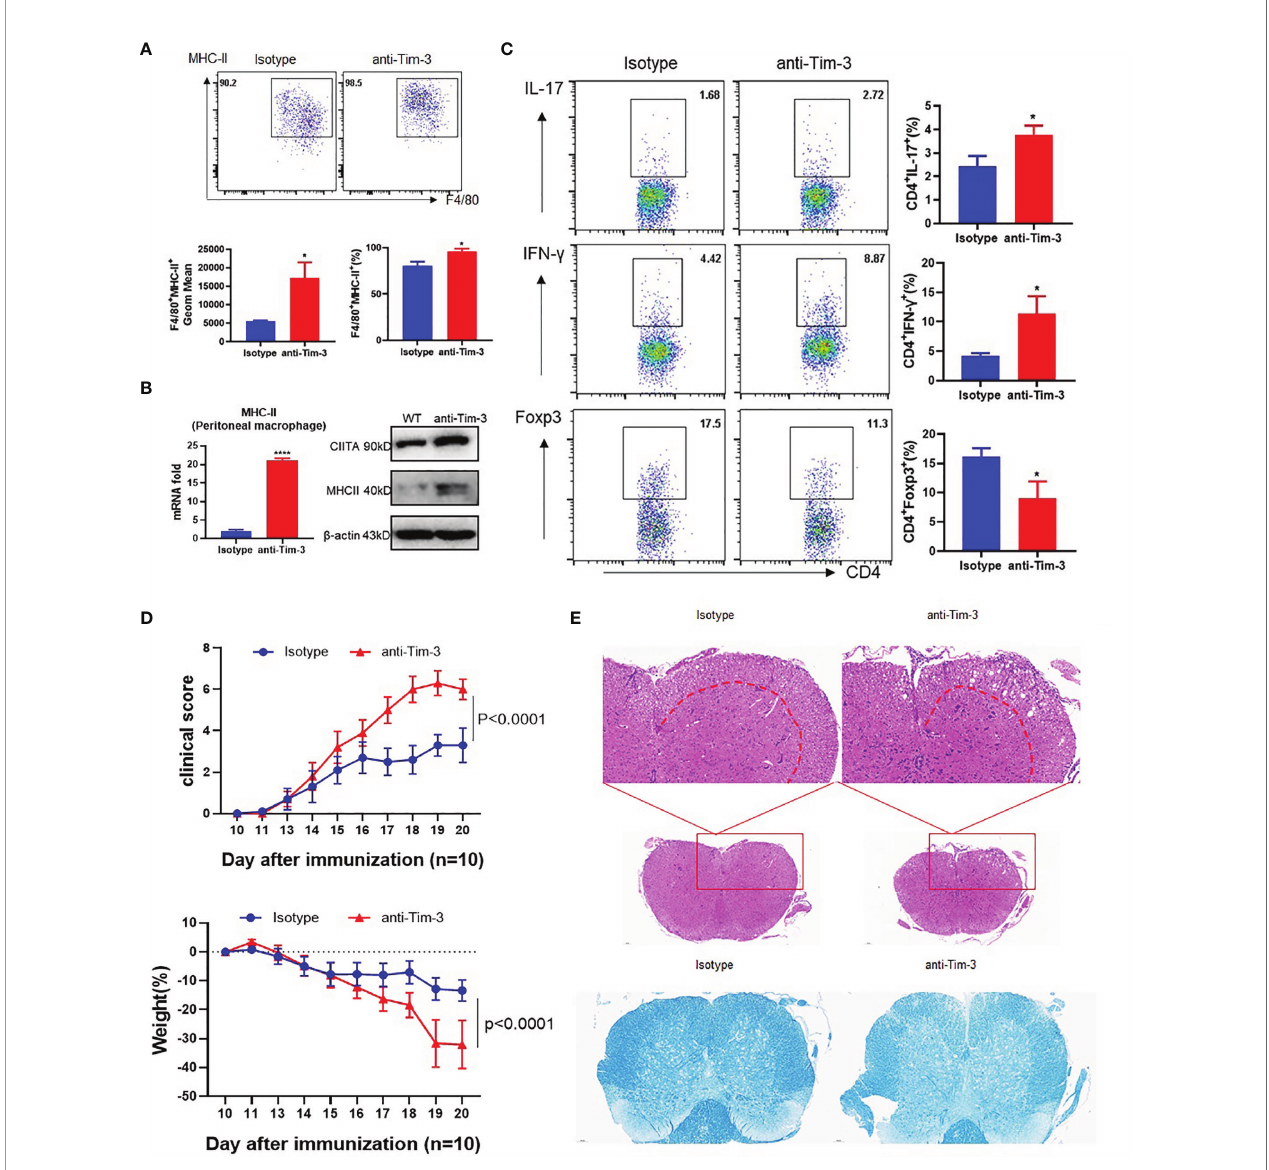
FIGURE 5 | Blockade of Tim-3 exacerbated multiple sclerosis in the EAE model. MOG was emulsi fi ed into CFA, mice were immunized subcutaneously, and pertussis toxin (500 ng/mouse) was injected intraperitoneally at 2 and 48 h after immunization. The immunized WT mice were divided into two groups (n = 10): one group is injected with anti-Tim-3 antibody, and the other group is injected with isotype antibody (10 mg/kg, intraperitoneal injection every other day. On the 20th day after immunization, the mouse spinal cords, peritoneal macrophages, and spleens were harvested. (A) Flow cytometry was used to detect the expression of MHC-II on the surface of macrophages. The percentage of MHC-II and the GeoMean were counted (mean ± SD, n = 5), (B) and the expression level of MHC-II was detected by RT-PCR (mean ± SD, n = 6) and Western blotting. (C) Flow cytometry was used to detect the activation levels of IL-17 + CD4 + T, IFN- g + CD4 + T, and Foxp3 + CD4 + T cells in splenic lymphocytes (mean ± SD, n = 6 – 10). (D) The weight and clinical scores of the EAE mice were recorded from the 10th day. (E) The mouse spinal cord tissue was isolated and stained with HE and LFB (*p < 0.05; ****p <